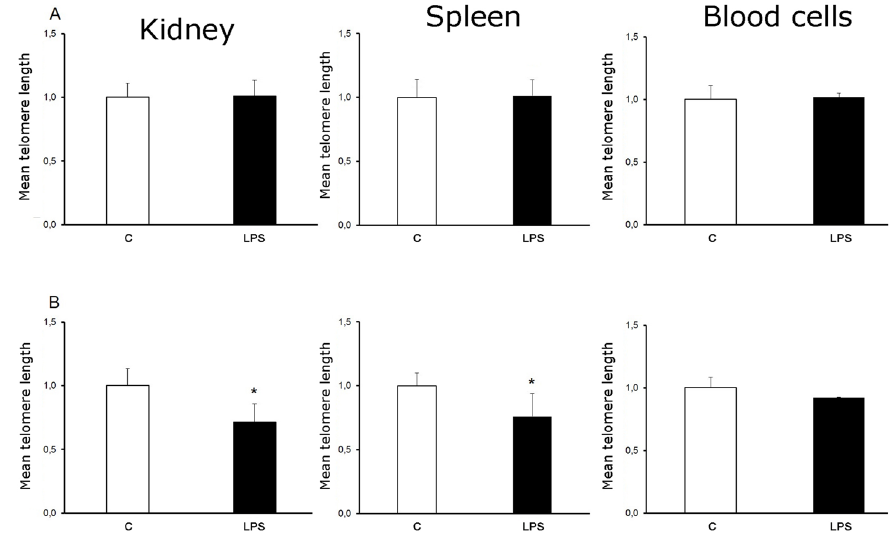
LPS exposure on telomere size (1 h). No change in telomere length was detected ( Figure 1A). However, at 48 h, LPS induced a significant and dose-dependent telomere shortening in the spleen and liver, and a tendency for decrease was noted in the blood (Figure 1B). None of the animals died in any of the experimental groups; ie, the current model represents a mild to moderate (nonlethal) form of sepsis. Human Sepsis induces Telomere Shortening in Blood Samples To extend the study to a human pop- ulation, we analyzed telomere length from blood samples of septic patients at admission and patients who developed sepsis 1 wk later. At 1 wk, telomere length was significantly reduced in septic patients (Figure 2). endotoxemia induces Oxidative Stress